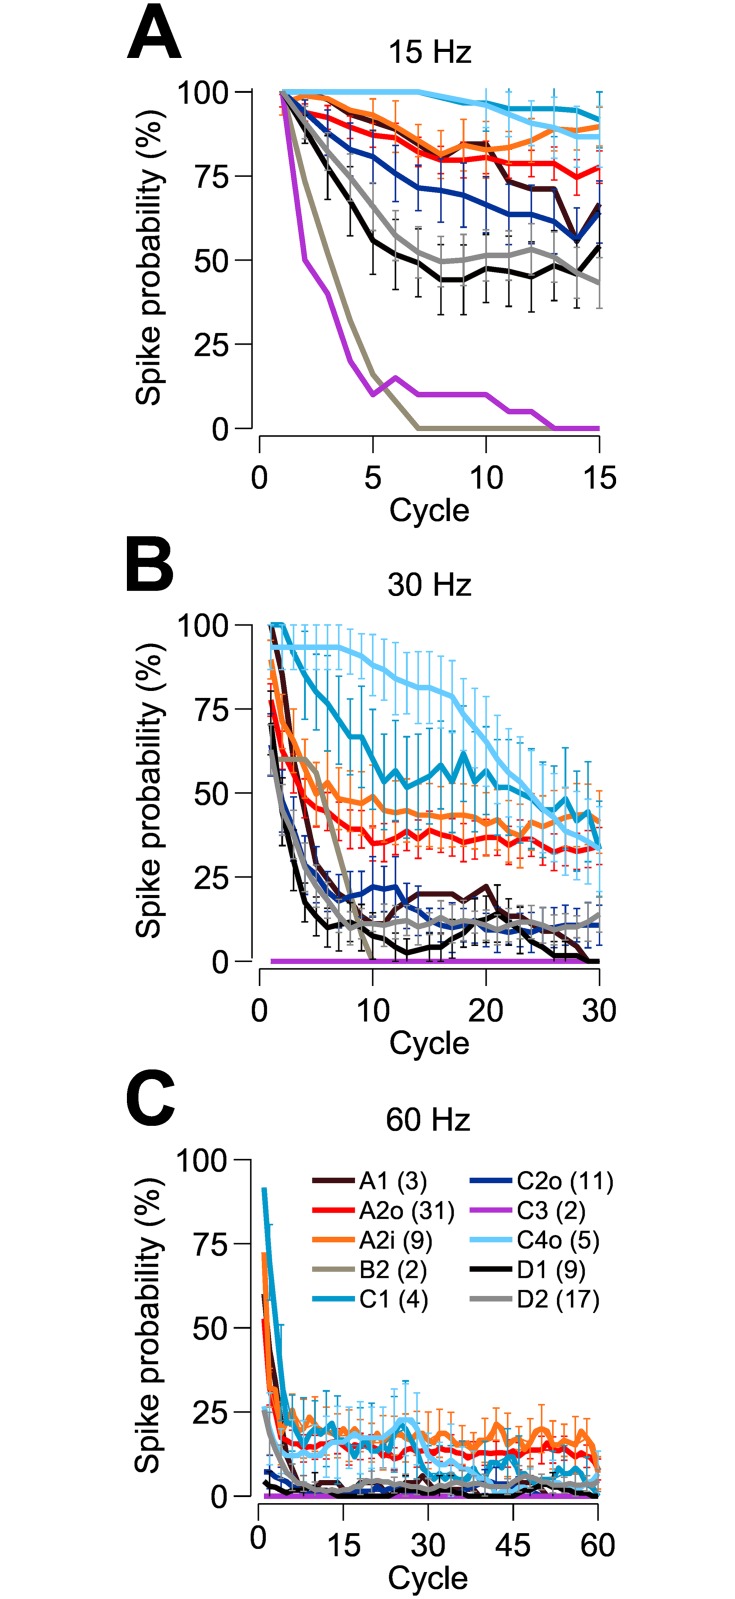
Temporal responses to sinusoidal stimulus currents.(A–C) Probability of observing a spike plotted against time (i.e., cycle count) within each stimulus presentation for stimulus frequencies of 15 Hz, 30 Hz and 60 Hz, respectively. Spike probability curves have been smoothed with a five-point moving average. Error bars indicating plus/minus one standard error have been included for cell types with n ≥ 4. Retinal ganglion cells exhibit a progressive decline in their ability to respond to the depolarizing phase of the stimulus over the course of the trial. This decline is more dramatic for some morphological cell types than for others, and becomes more pronounced as the stimulus frequency is increased.